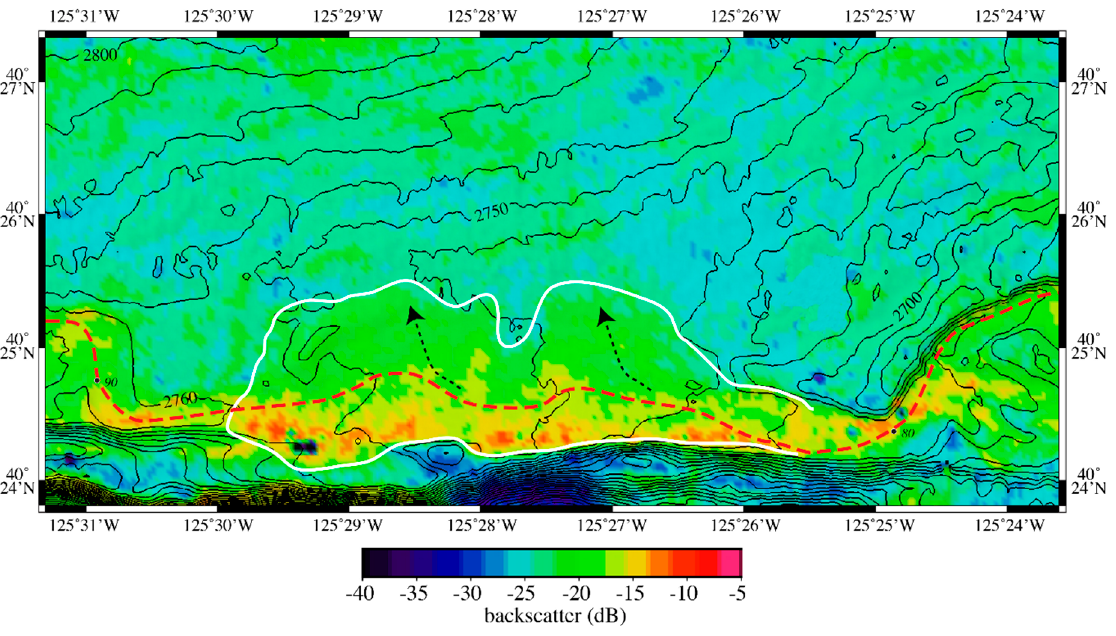
Figure 12. MBES backscatter image of crevasse splay with isobaths. White outline is the extent of the high-backscatter sediment of the crevasse splay that broke out of the channel towards the north (black dashed arrows). Red dashed line is the thalweg of Mendocino Channel. Black circles mark distances in km in italics from the junction of Mendocino and Mattole Canyons. Isobath interval 10 m, isobaths of Gorda Escarpment intentionally left unlabeled. See Figure 2 for location.